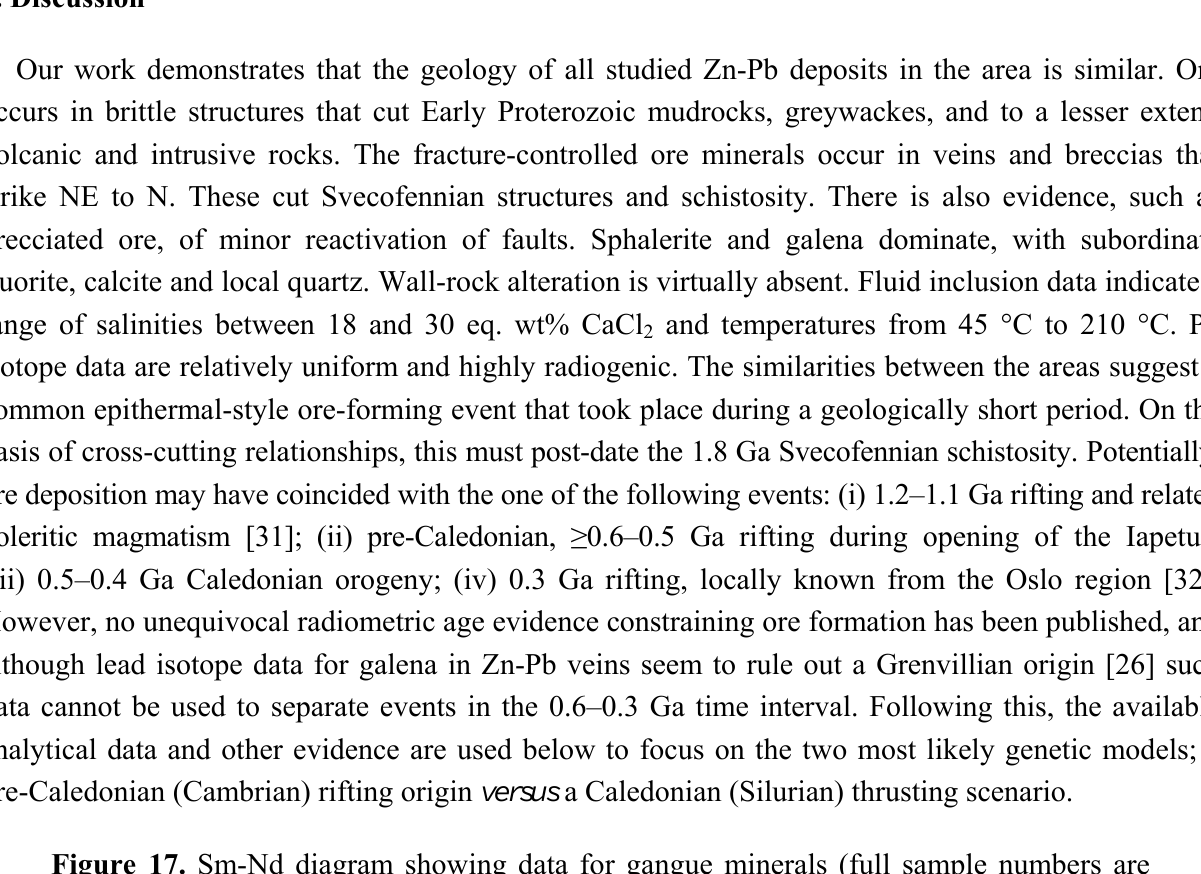
Figure 17. Sm-Nd diagram showing data for gangue minerals (full sample numbers are given in Table 4) from three fracture-controlled Zn-Pb deposits. The reference line is drawn to include all seven